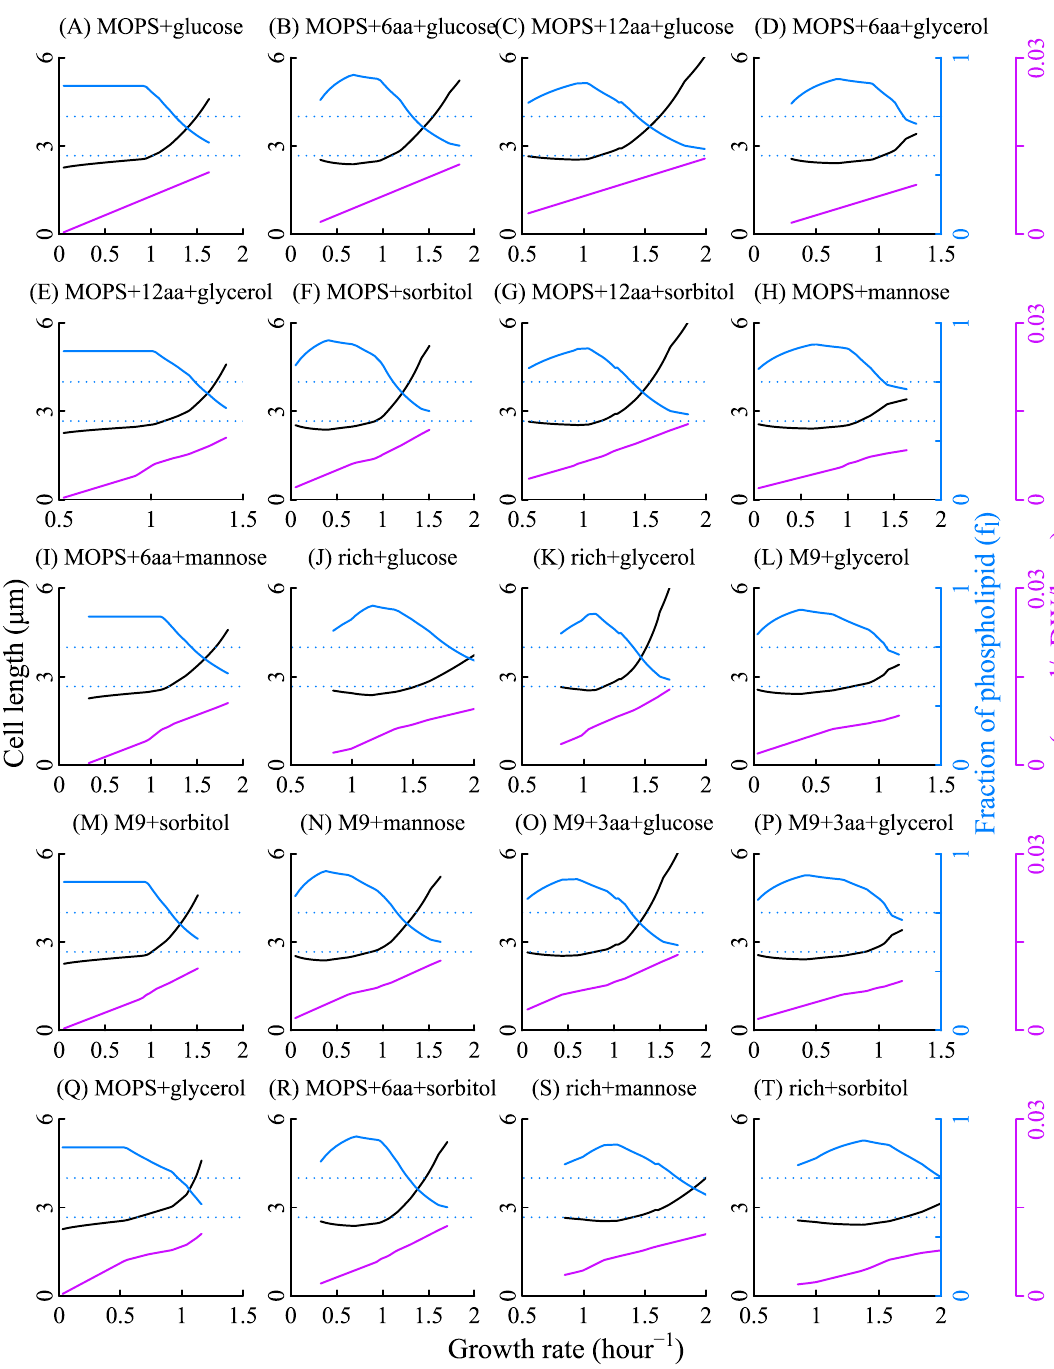
Figure A3. Relationships among growth rate, cell length, cardiolipin synthesis rate, and fraction area of phospholipid in membranes. The purple solid lines are the cardiolipin synthesis rate changing with the growth rate. As the sub-figure shows, the cardiolipin synthesis rate is nearly proportional to the growth rate in all culture media, except for the media containing kinds of amino acid. The blue solid lines represent the fraction area of the phospholipid in cell membranes. As growth rate increases, f l does not change smoothly at some points; it is the same for r CLPNS . Data in each sub-figure is from a series of simulations corresponding to the same kind of culture